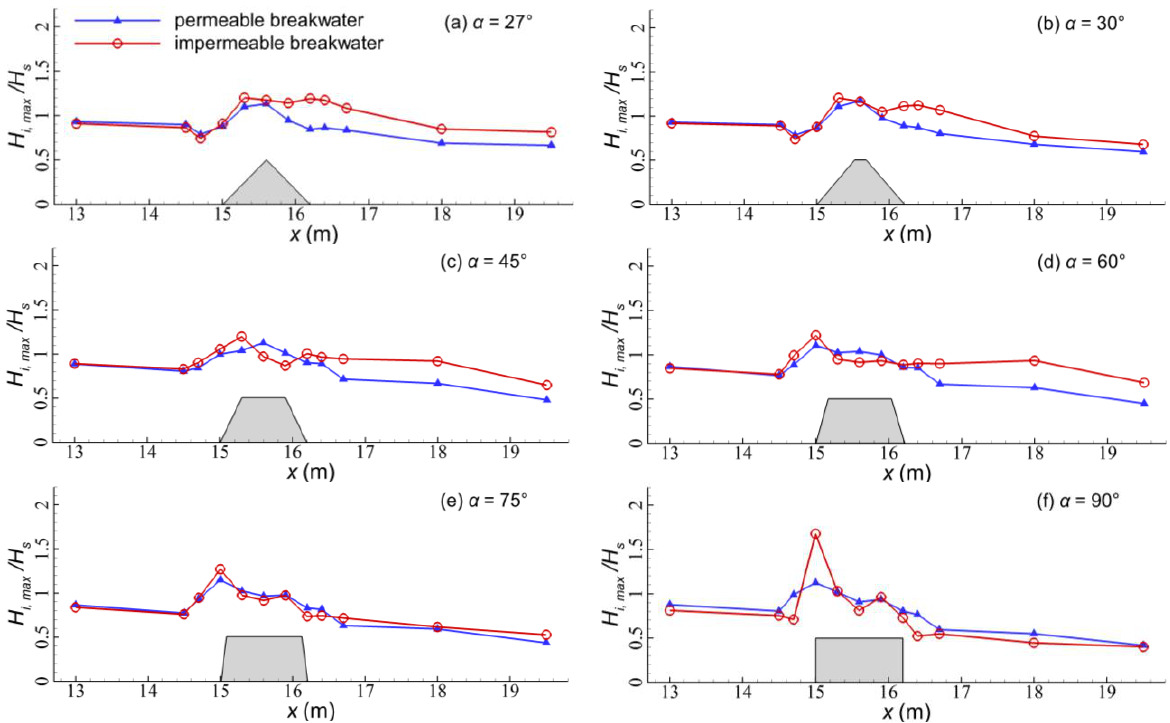
Figure 25. Spatial distribution of maximum local wave heights with different side slope angles; ( a ) 𝛼 = 27 ° ; ( b ) 𝛼 = 30 ° ; ( c ) 𝛼 = 45 ° ; ( d ) 𝛼 = 60 ° ; ( e ) 𝛼 = 75 ° ; ( f ) 𝛼 = 90 ° .